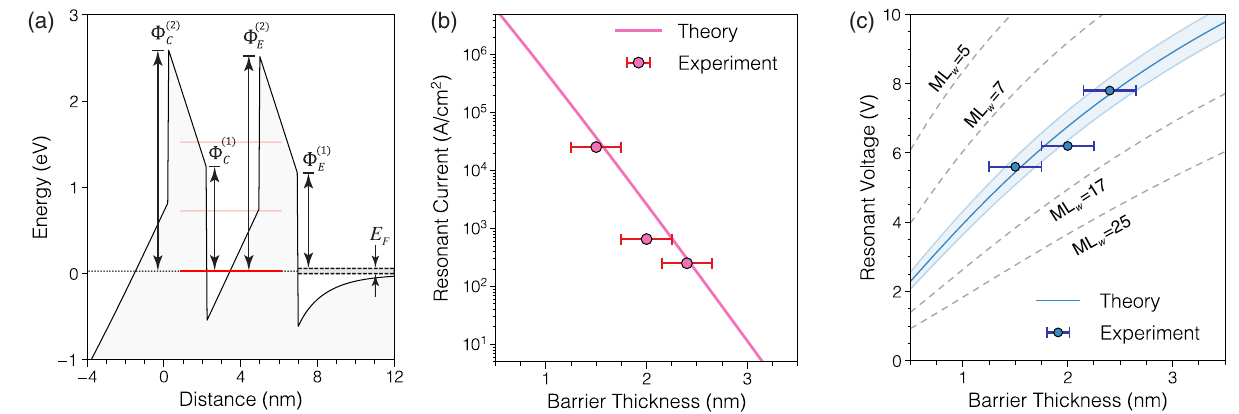
FIG. 7. (a) Band diagram of a GaN = AlN double-barrier heterostructure at resonance showing the various energy barriers considered in the calculation of the resonant tunneling current. (b) Resonant tunneling current as a function of barrier thickness predicted by our analytical model. The experimental values were measured in a set of RTDs with variable barrier thickness exhibiting NDC at room temperature. The heterostructures feature a doping concentration N d ∼ 2 × 10 19 cm − 3 and spacers of thickness 10 and 6 nm in the emitter and collector region, respectively. The error bars indicate (cid:2) 1 -ML ( (cid:2) 0 . 25 -nm) fluctuations in the AlN barriers. (c) Resonant voltage V as a function of the barrier thickness and width of the quantum well in monolayers (ML w ) for a GaN = AlN RTD. The shaded res region shows the effect of 1-ML fluctuations around an 11-ML GaN well. The experimental values were measured at room temperature in the same set of devices reported in